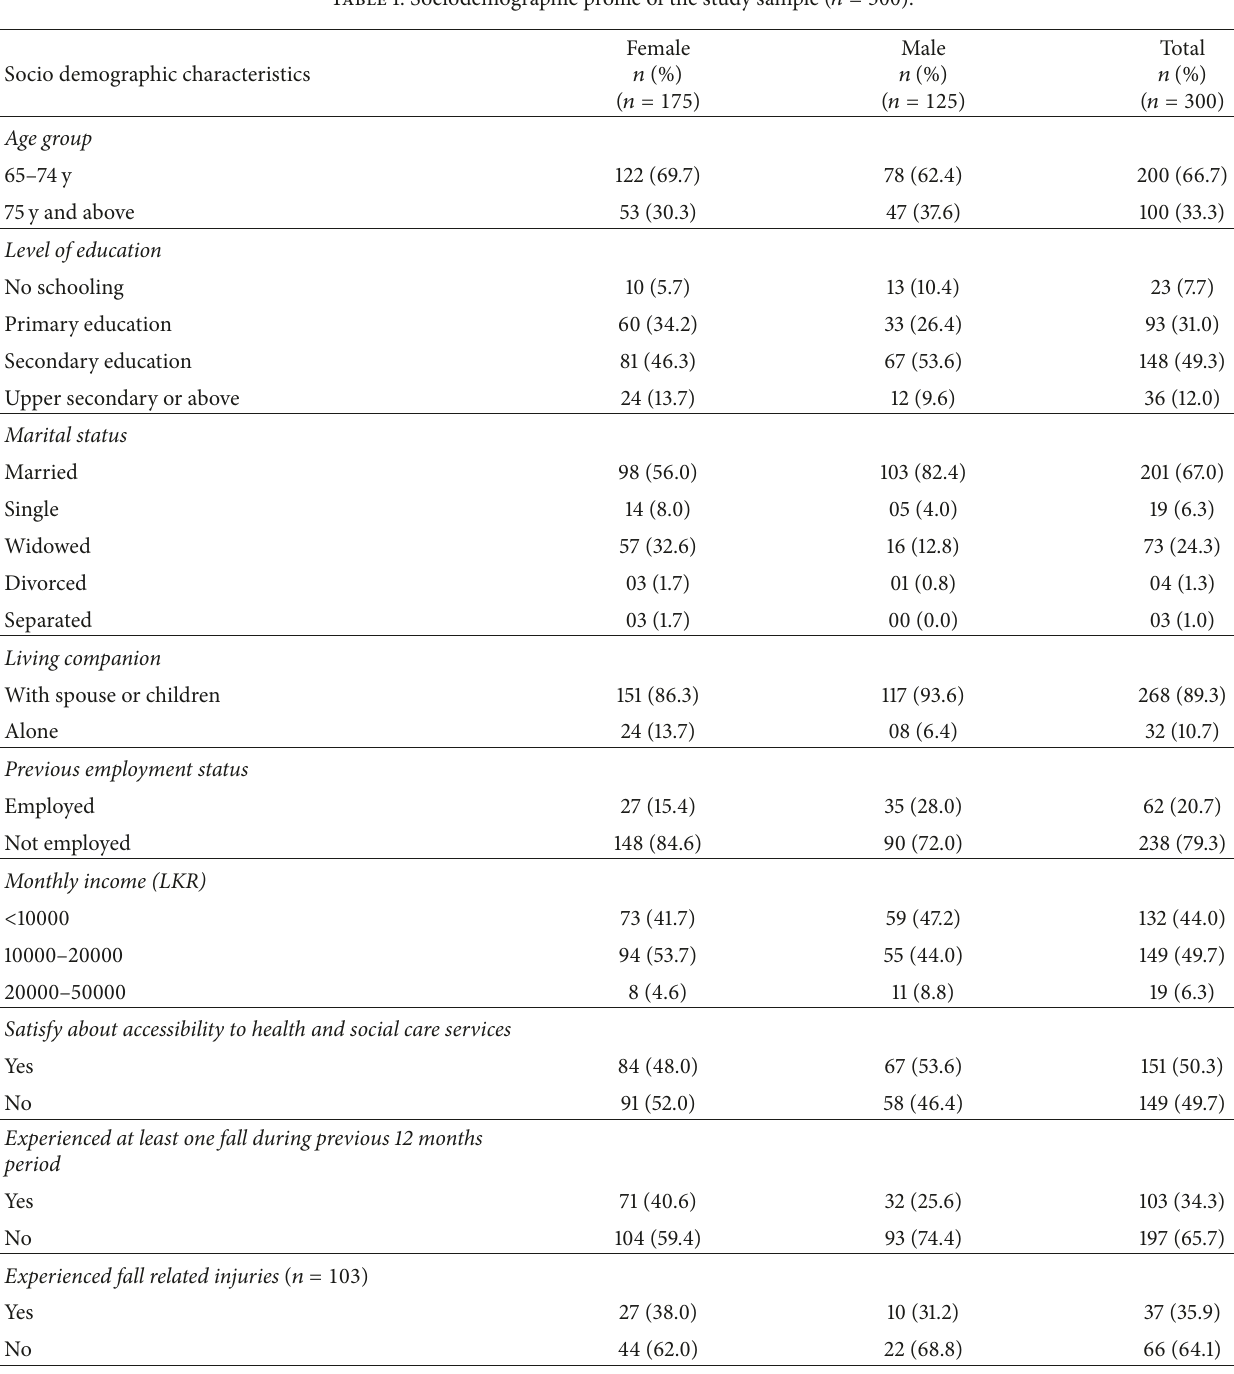
Table 1: Sociodemographic profile of the study sample ( 𝑛 = 300